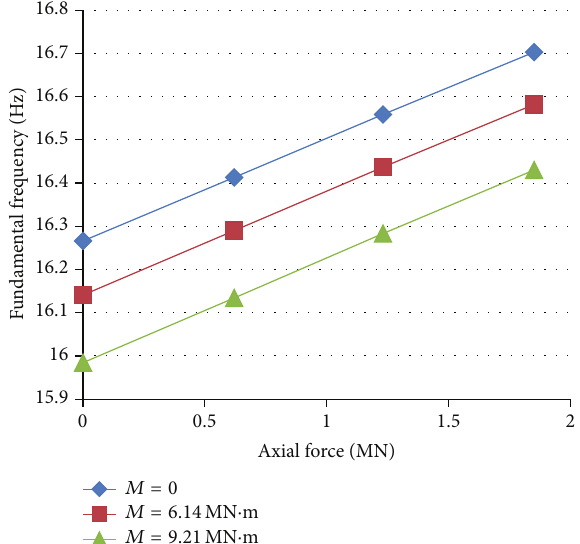
Figure 6: Variation of natural frequencies when tensile force and end moment are applied for clamped-clamped boundary